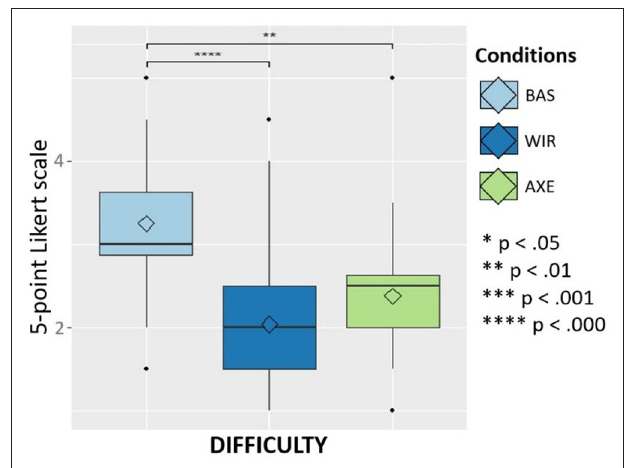
a Friedman test was used that showed no significant difference between the conditions [ χ ² (2) = 1.76, p = 0.41 ]. Consequently, H2(a) and H2(b) were rejected.